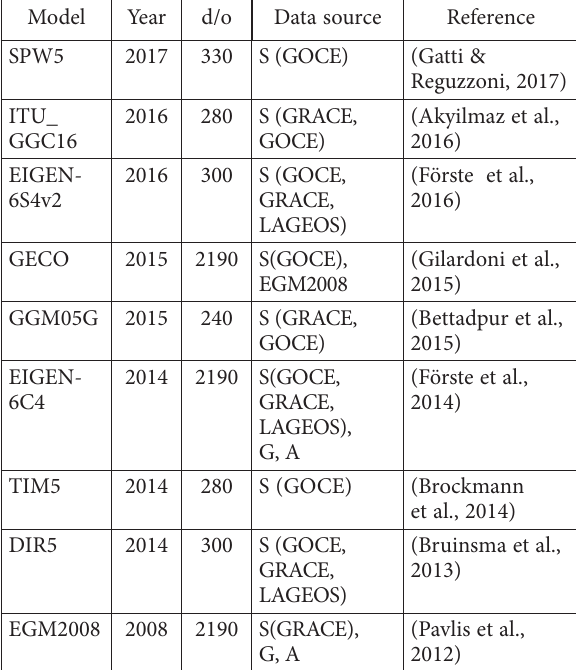
Table 1. Models under